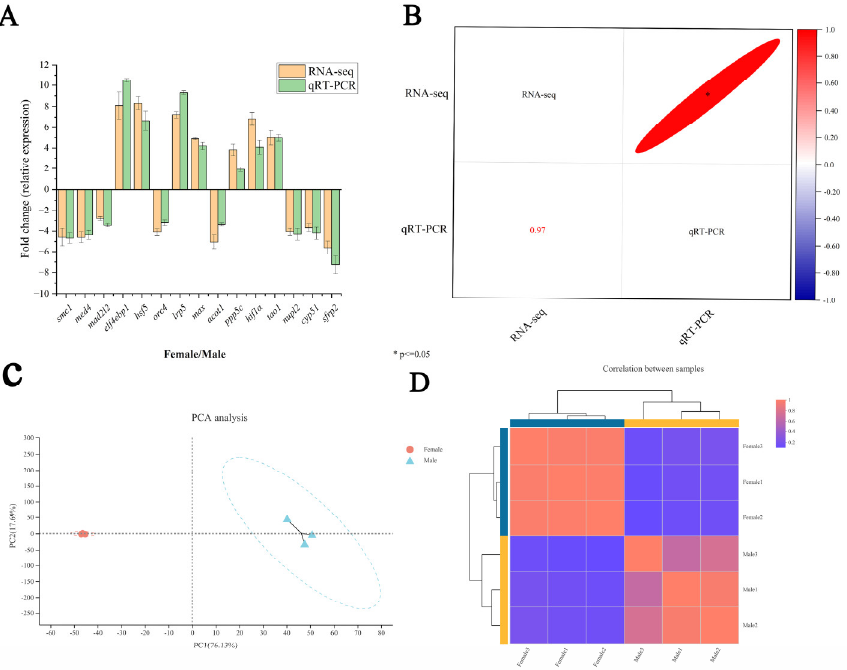
Figure 1. Transcriptome data validation. ( A ): Log 2(Fold change) analysis between female and male. ( B ): Pearson correlation analysis of qRT − PCR and RNA − Seq data. ( C ): PCA analysis of female and male data. ( D ): female and male correlation